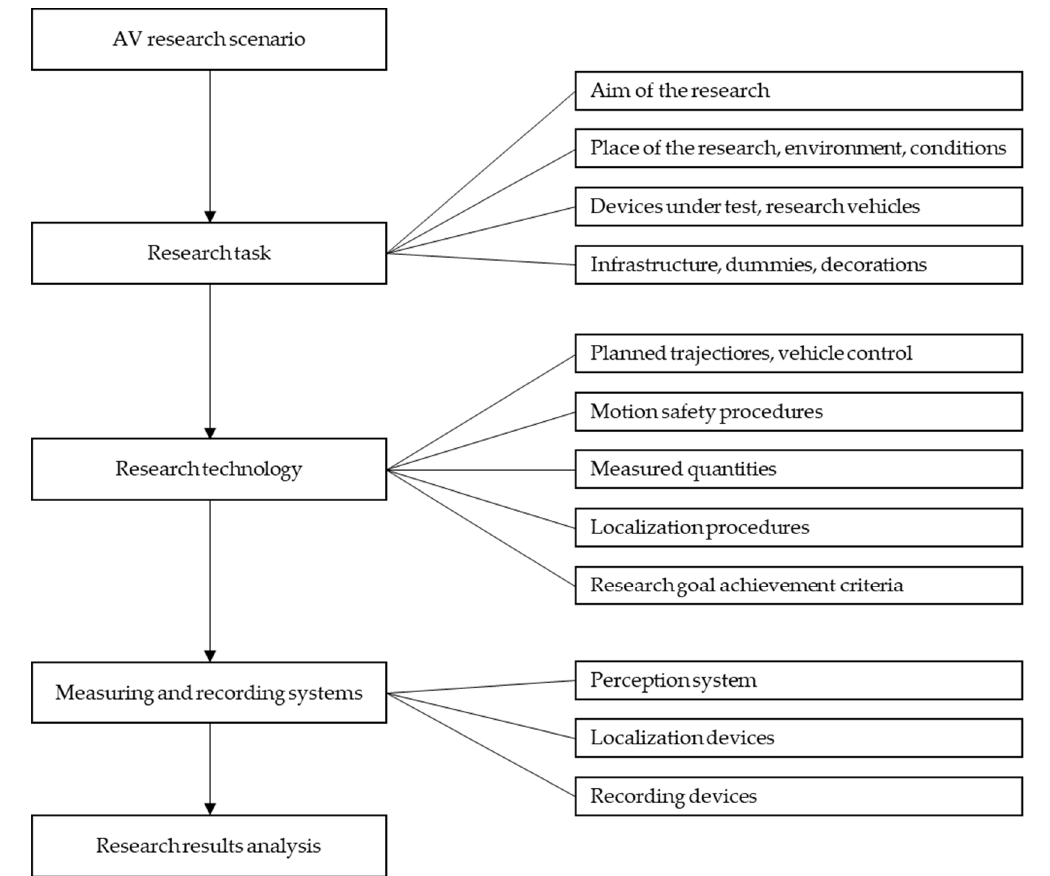
Figure 1. Hierarchical information diagram for AV research scenarios.